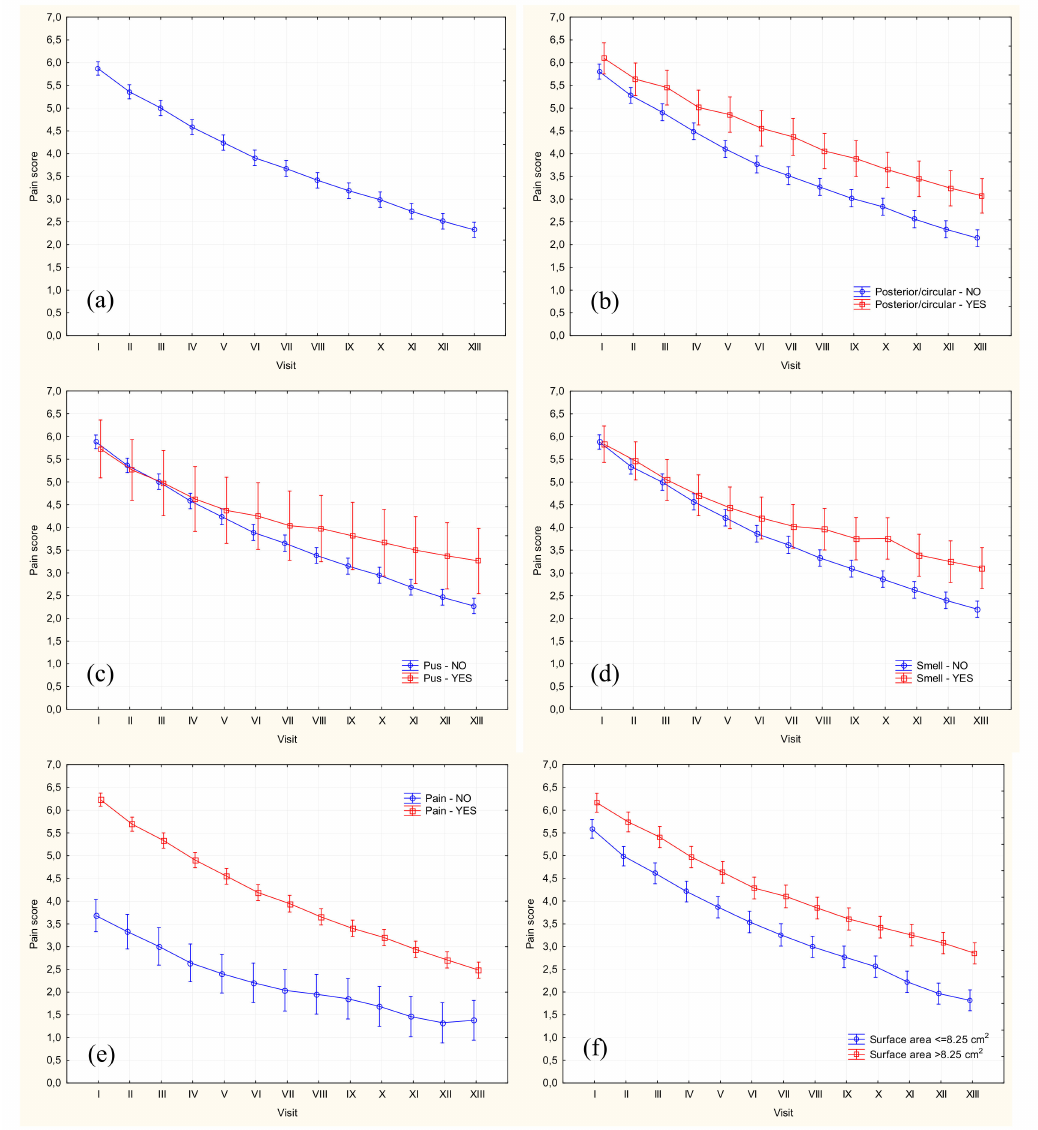
Figure 1. Mean pain scores ( ± 95% confidence intervals) overall ( a ) and according to ulcer characteristics: presence of posterior / circumferential ulceration ( b ), presence of pus ( c ), unpleasant smell ( d ) and / or pain / tenderness during the first visit ( e ), and surface area at the baseline ( f ). Visit I denotes enrollment visit at Week 0 and visit XIII the last visit at week